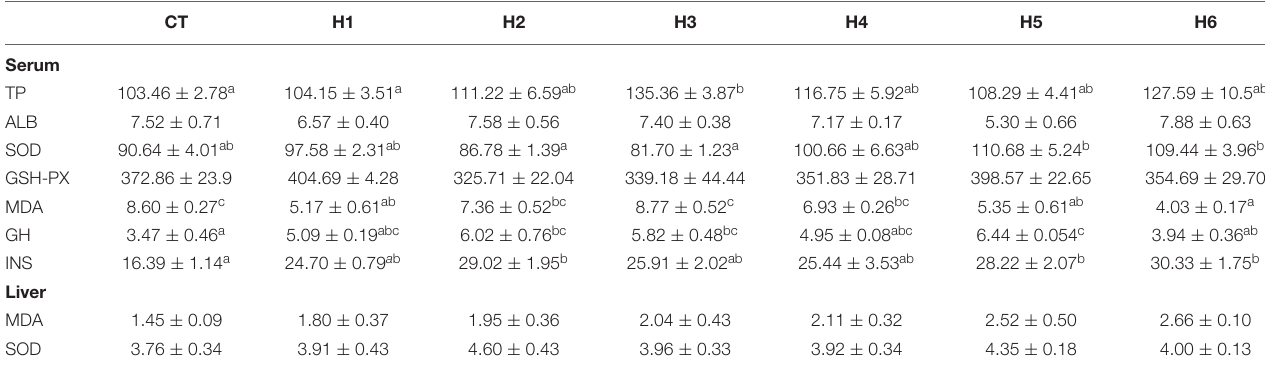
Values are mean values of each group of hybrid grouper (three replicates) ± SE. Means in each row without superscript do not differ significantly (p > 0.05), while those with superscript differ significantly (p < 0.05). GH, growth hormone; INS, insulin; TP, total protein; ALB, albumin; SOD, superoxide dismutase; MDA, malondialdehyde; GHS-PX, glutathione peroxidase. TABLE 6 | Effect of hydrolyzed fish protein powder on mRNA IGF-I and TOR expression in the intestine, muscle, and liver of juvenile pearl gentian hybrid grouper. CT